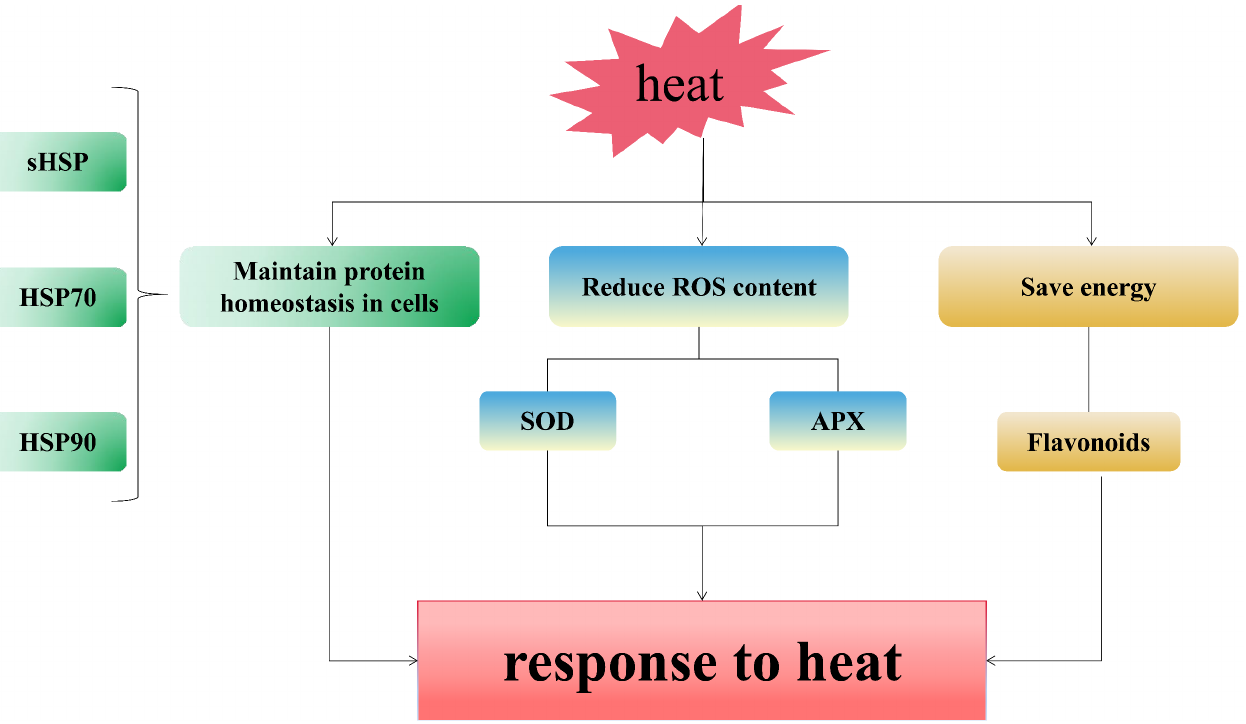
Figure 5. The response process changes in pearl millet with the passage of heat stress. Table 2. Expression of Protein Folding Related Genes in Pearl Millet Leaves under Heat Stress for 1 h. Annotation